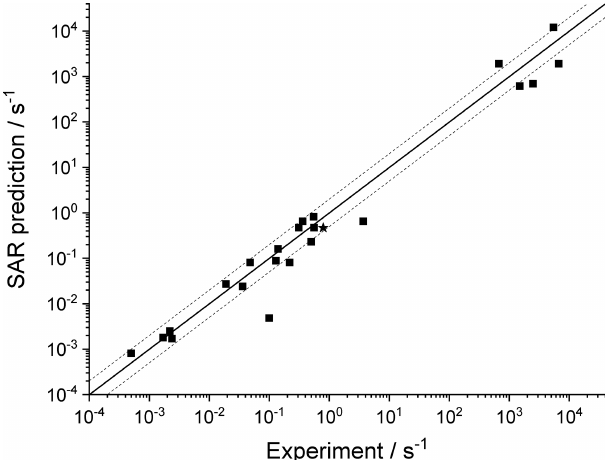
Figure 3. Comparison of the experimental values against the SAR predictions (various temperatures). The solid line shows a 1 : 1 agreement, with the dotted lines delineating a factor of 2 of uncer- tainty. The star indicates a rate ratio (see Table